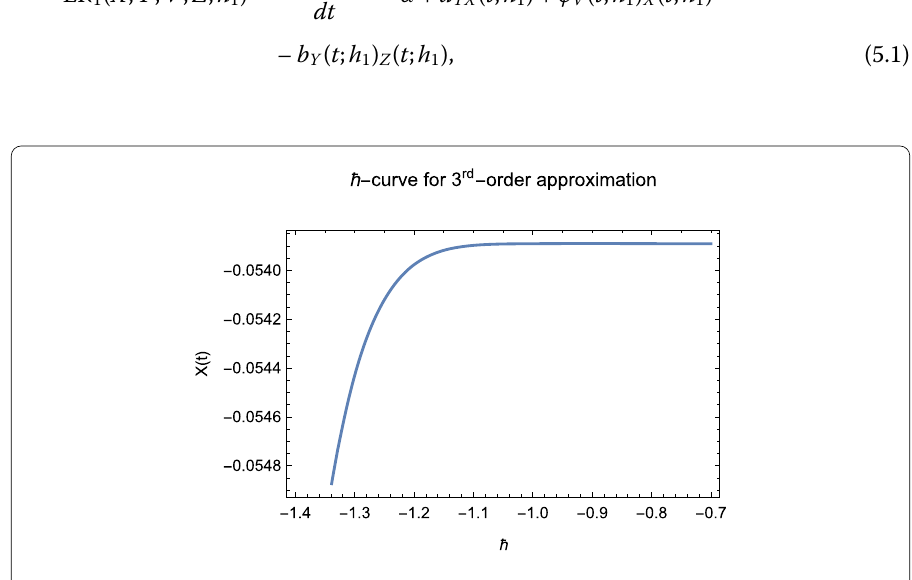
Figure 2 The h -curves of the third-order approximations for X ( t